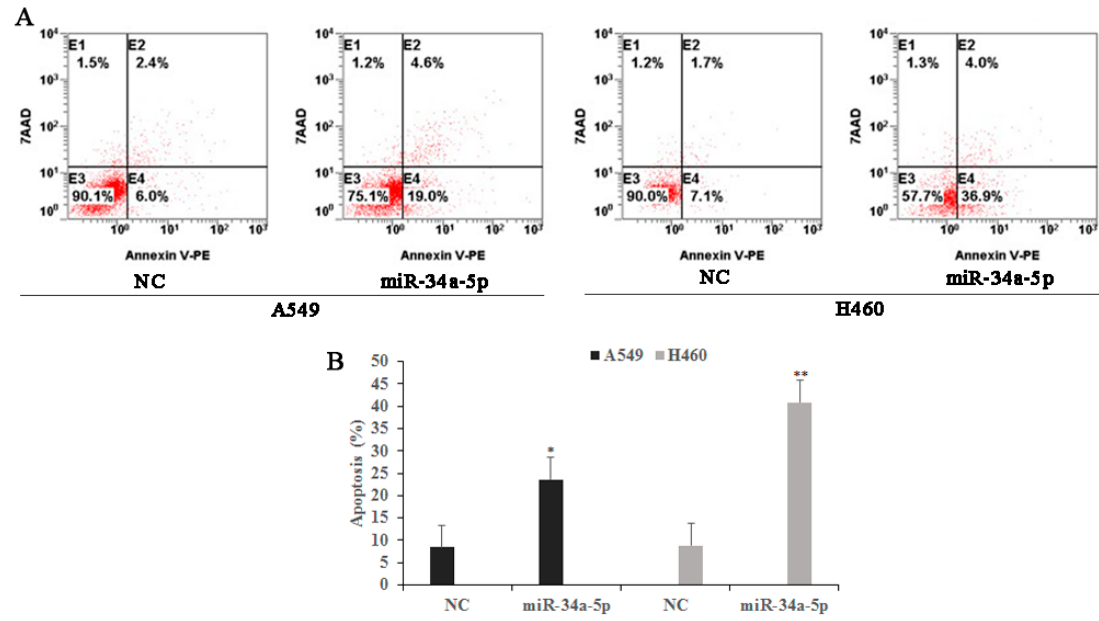
Figure 8. The effects of miR-34a-5p on tumor cell apoptosis in A549 and H460 cells. Both cells were transfected with either a miR-34a-5p expression vector or a miR-34a-5p negative control. ( A ) Twenty-four hours after transfection, cell apoptosis was measured by flow cytometry; ( B ) Bar graphs represent the proportion of early and late stage apoptosis cells. The results are expressed as means ± SD of three independent experiments. * p < 0.05, ** p < 0.01, compared with the negative controls (NCs).